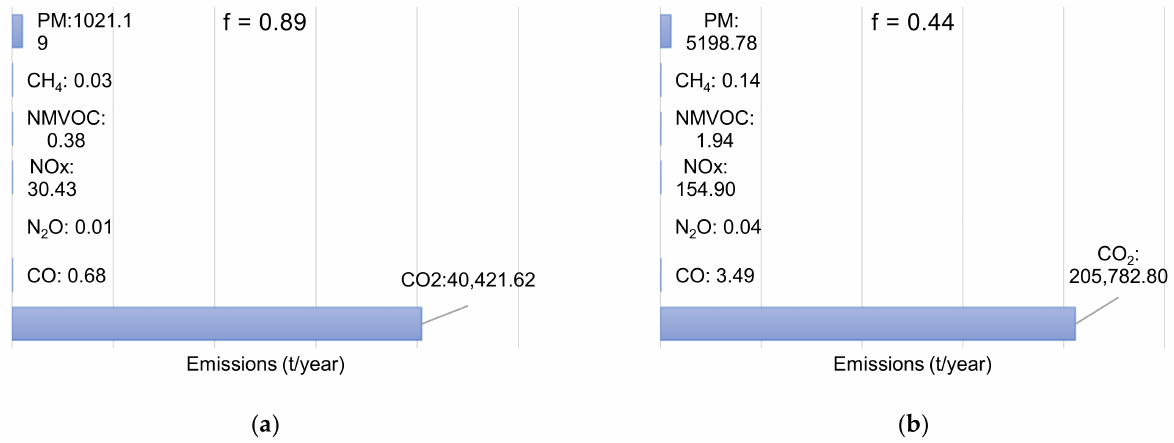
Figure 5. Estimated emissions for different solar fractions. ( a ) f = 0.89; ( b ) f =